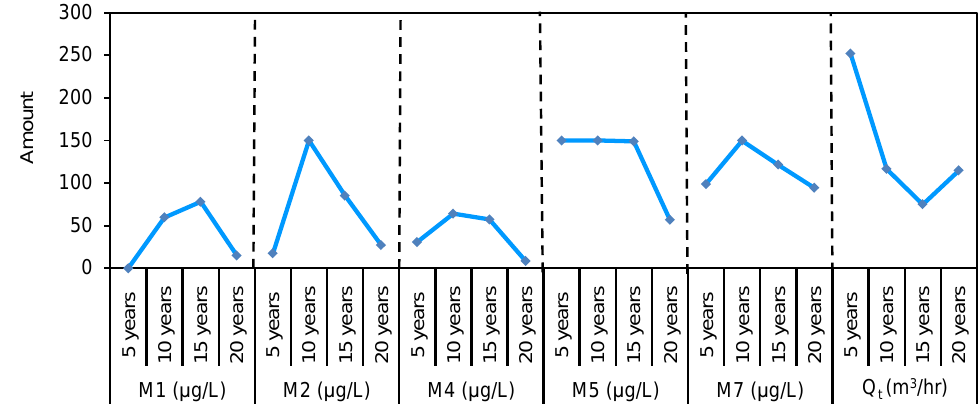
Figure 2. The optimal solutions when the environmental standard is 150 μg/L and the acceptable health risk is 0.00044. Q t is optimal total pumping rate (m 3 /h), M i is residual concentration in the monitor well (μg/L).